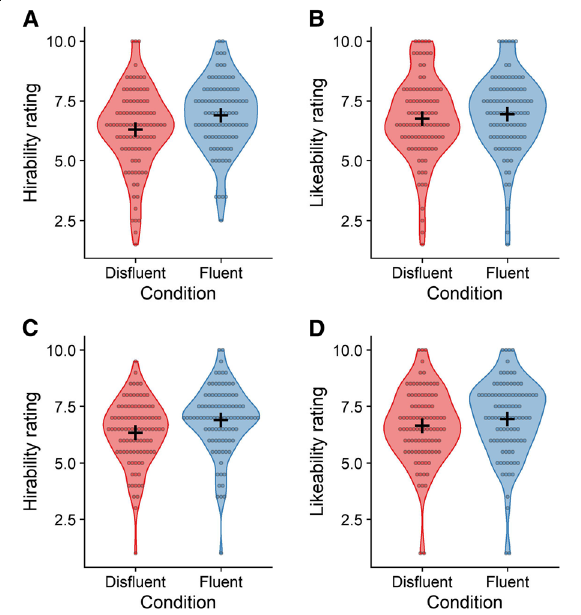
Fig. 1 Hirability and likeability ratings as a function of AV fluency in experiments 1 ( a , b ) and 2 ( c , d ). Circles represent the mean rating for each participant. Crossed lines indicate condition